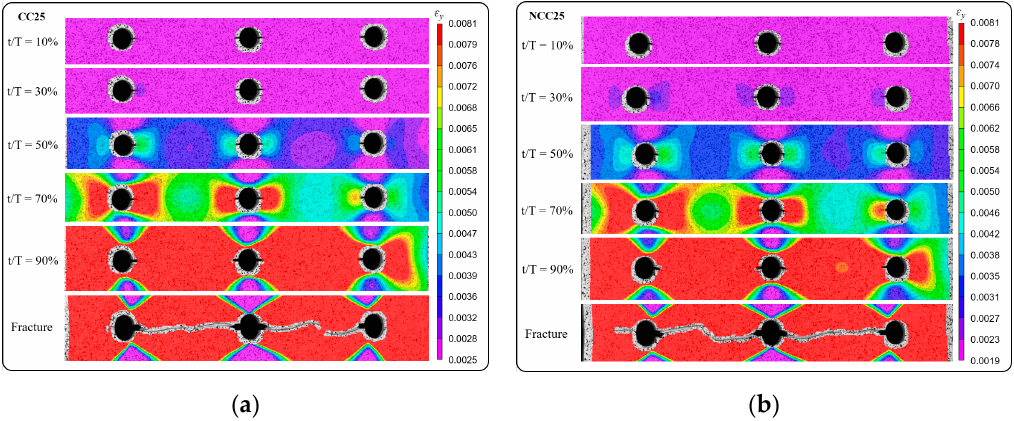
Figure 4. Evolution of ε y of ( a ) CC25 and ( b ) NCC25. At t/T = 30%, the full field strain was little. The hollow pre-notched zones displayed an area of strain concentration which was larger than the other areas at t/T = 50%. When t / T gradually rose to 70%, obvious strain clusters firstly appeared at the tips of cracks and finally, the specimens failed in the form of instantaneous fracture.